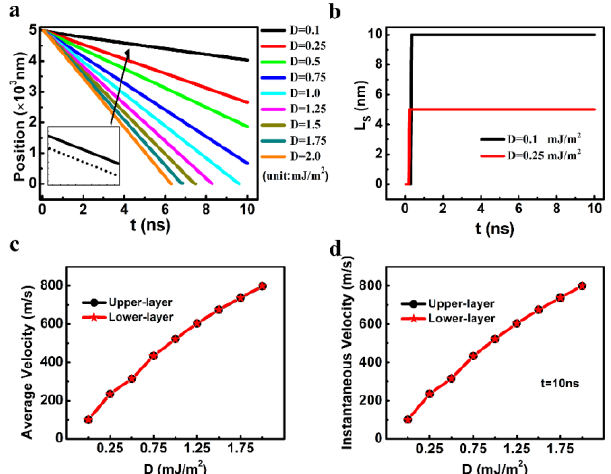
Figure 3. ( a ) The temporal central positions of the magnetic domain walls (DWs) in the two layers (The solid and dashed lines represent the results in the upper layer and in the lower one, respectively.), ( b )thetemporallengthofthestaggereddomainsofthesyntheticantiferromagnets(SAF)racetrack, ( c )the averagevelocity, and( d )theinstantaneousvelocityoftheDWasafunctionoftheDzyaloshinskii–Moriya interaction (DMI) constant. Other parameters of J ex , K L , K U were fixed as − 0.3 mJ / m 2 , 2.5 × 10 5 J / m 3 , and 6 × 10 5 J / m 3 , respectively.